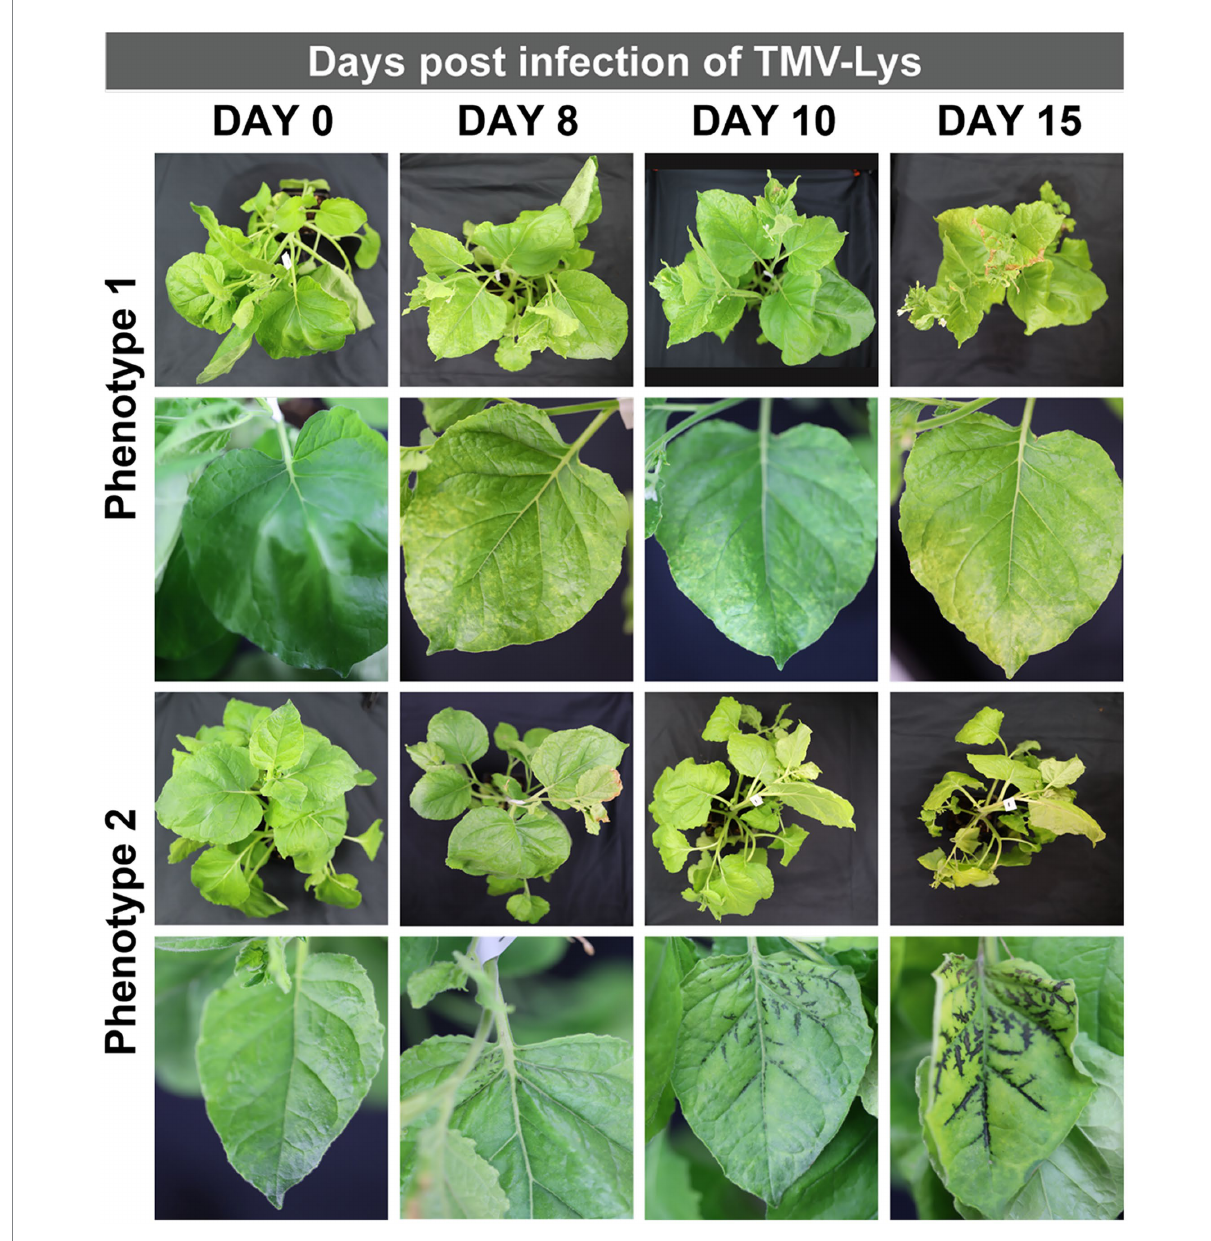
FIGURE 5 Representative symptoms of N. benthamiana infected with TMV-Lys. Phenotype 1, shows generalized yellow mottling of the leaves increasing with time. Phenotype 2, shows the blackening of veins with the simultaneous yellowing of the